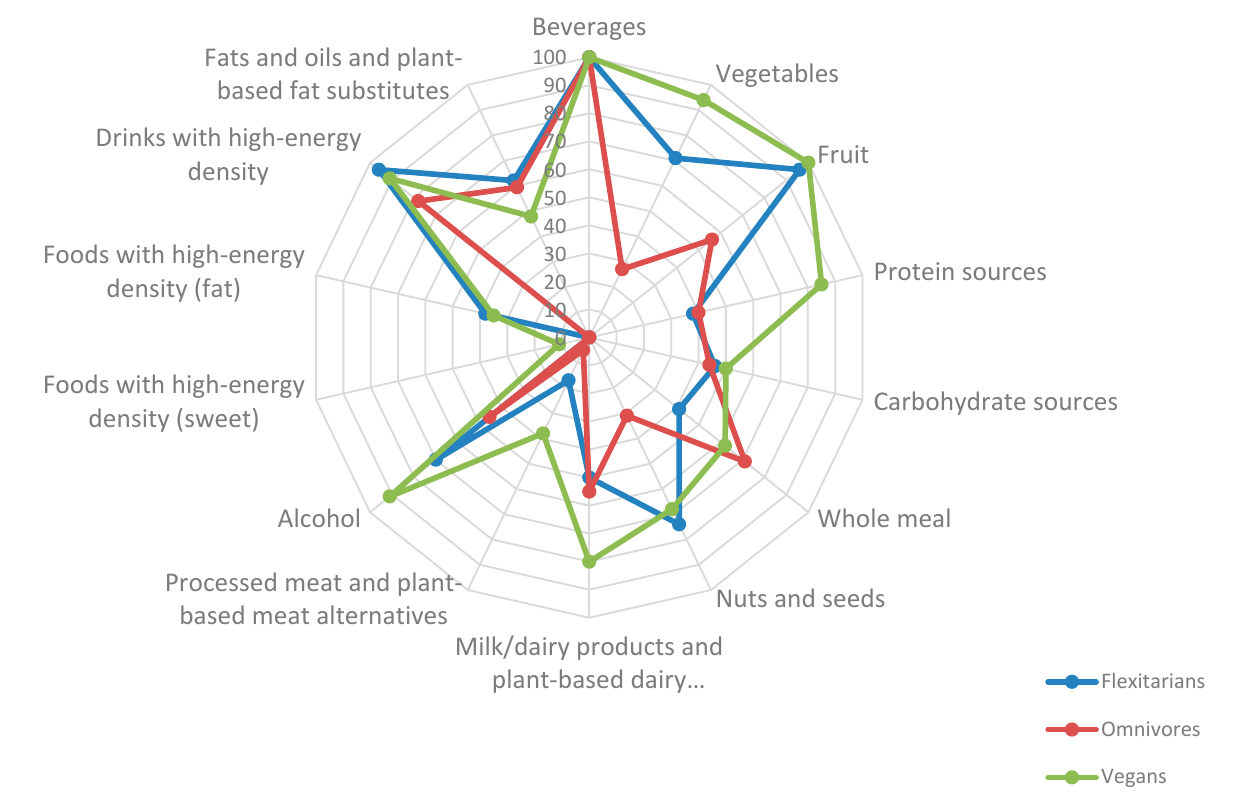
Figure 1. Total score points of flexitarians, vegans and omnivores subdivided by HEI-flex components in a network graph. Plot of the median score values of flexitarians, vegans and omnivores subdivided by the 14 components of the HEI-flex (SP min 0/SP max 100) in a network graph. HEI-flex = Healthy Eating Index—flexible.